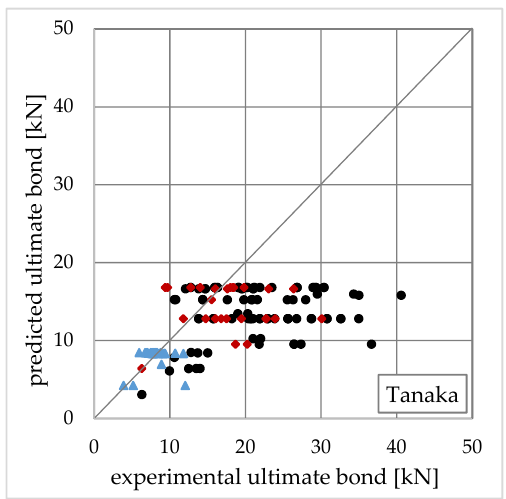
Figure 2. Test vs. predicted bond force using the Tanaka model [14]. Appl. Sci. 2020 , 10 , 8593